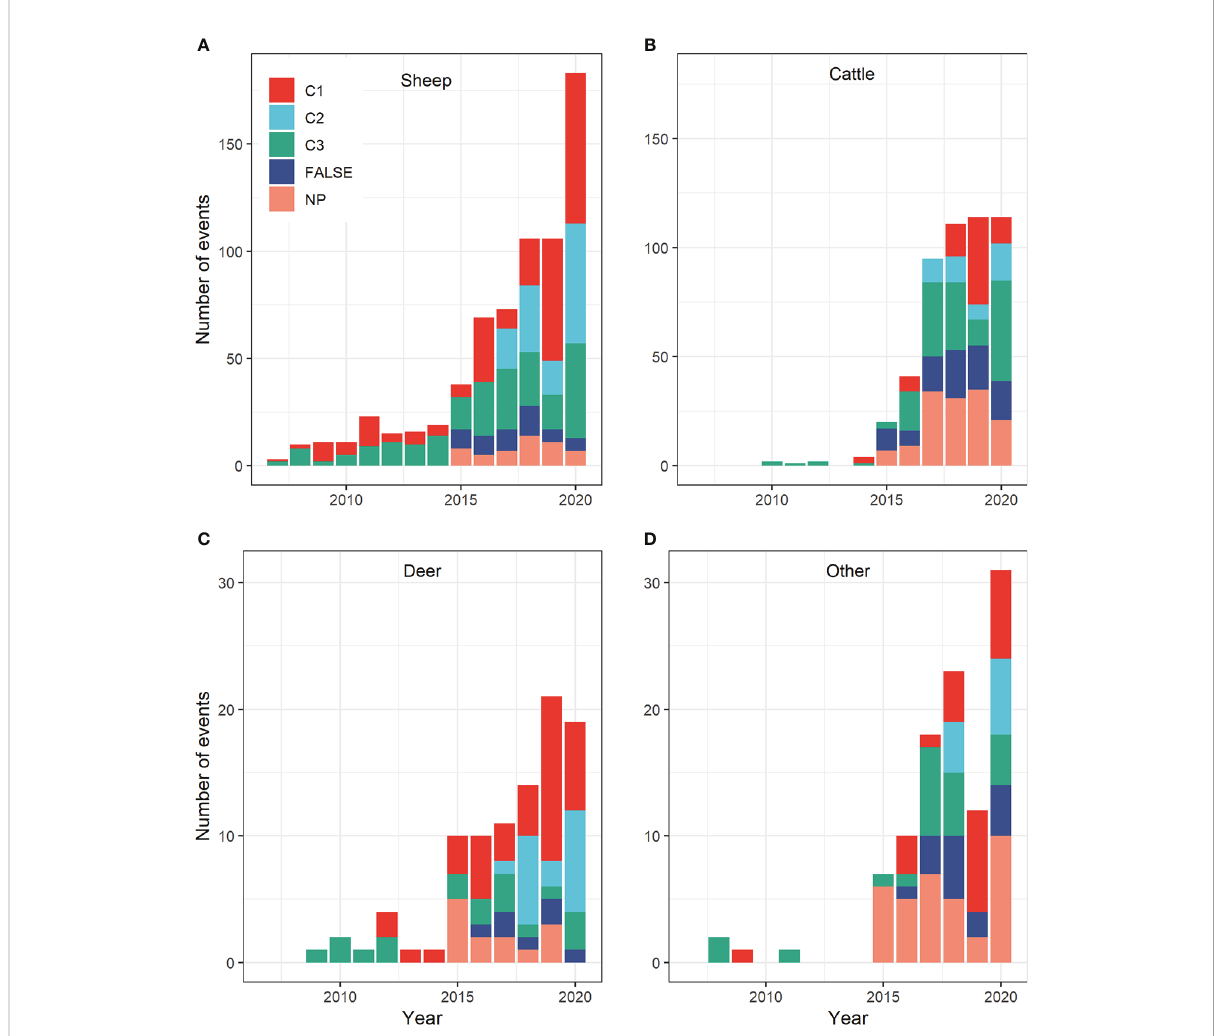
FIGURE 3 Number of reported wolf predation events in Brandenburg state (Germany), strati fi ed by monitoring category (C1: clear evidence; C2: con fi rmed hint; C3: uncon fi rmed hint; FALSE: livestock loss not caused by wolves; NP: evaluation not possible) and calendar year for (A) sheep, (B) cattle, (C) farmed deer, and (D) other livestock species. Note the different y-scales in the upper and lower